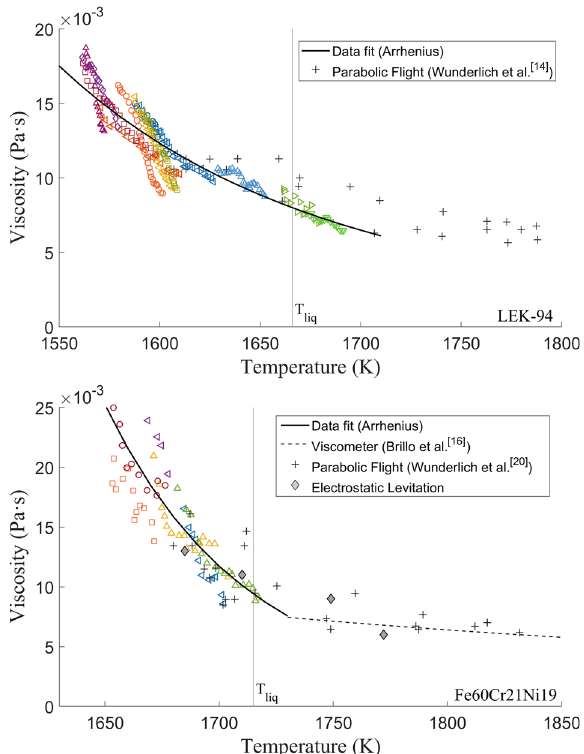
Fig. 6 Viscosity as a function of temperature for molten LEK-94 and Fe60Cr21Ni19. Each open symbol represents results from different tests using the ISS-EML; the solid lines represent Arrhenius fi